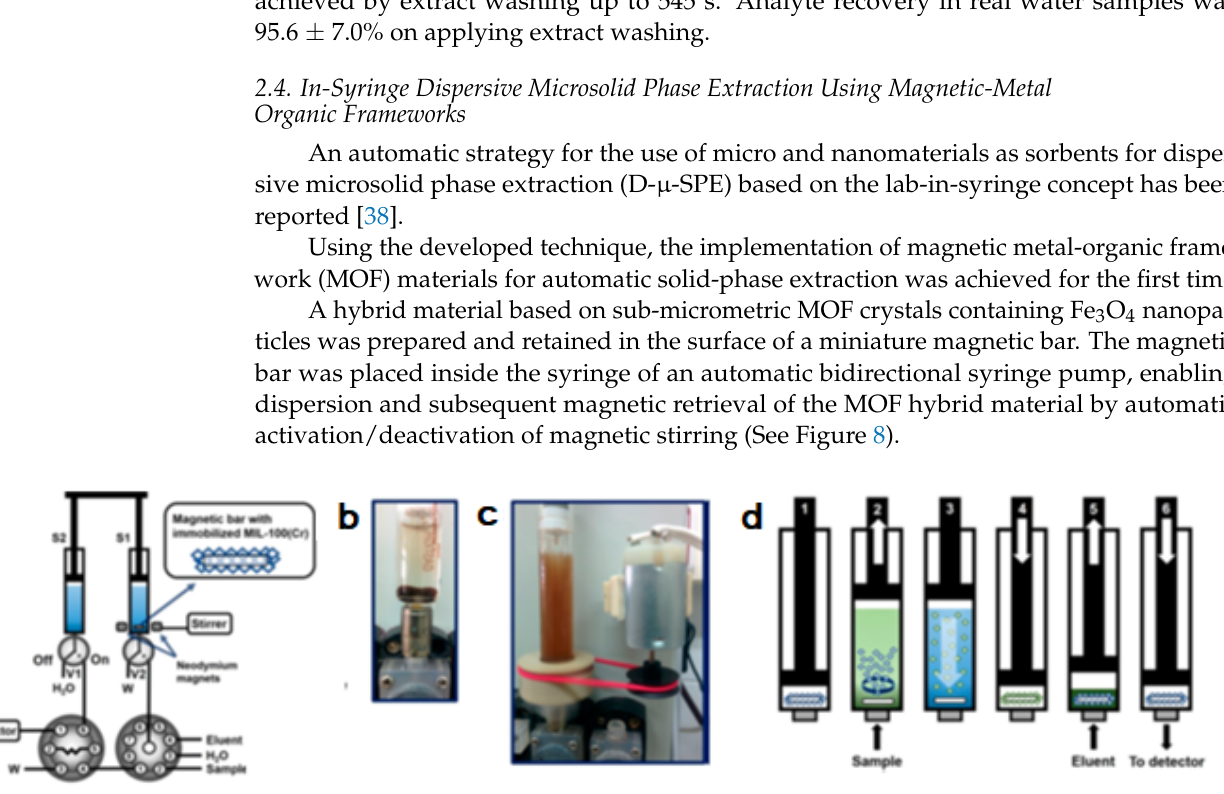
glass syringes; W, waste reservoir; ( b ) Magnet coated with 10 mg of magnetic MOF placed inside a 5 mL glass syringe; ( c ) In ‐ syringe dispersion of a magnetic MOF facilitated by magnetic stirring; ( d ) Schematic depiction of the extraction procedure in syringe 1 (washing step between extraction and elution is not included) [38].